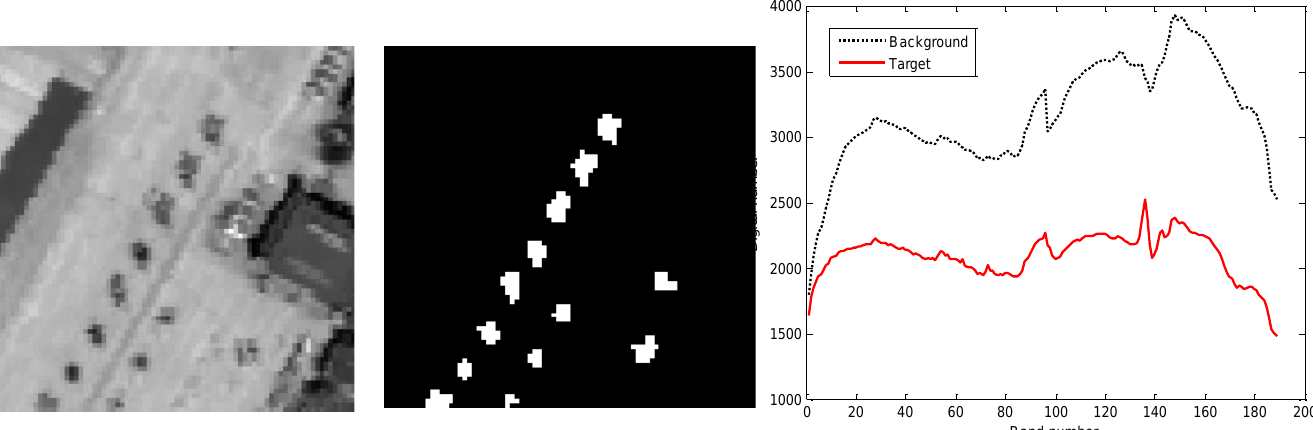
Figure 2. The grey level image, target map, and spectral signatures of target and background in real AVIRIS image.